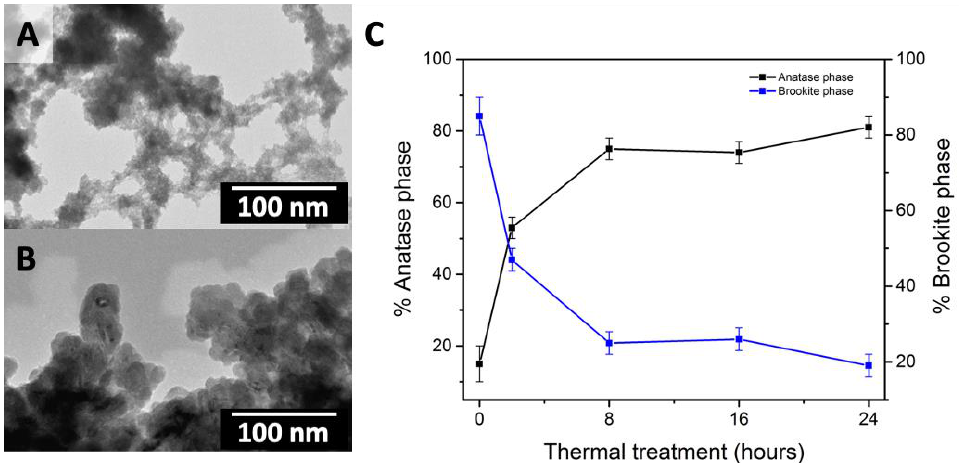
Figure 2. Transmission electron microscopy (TEM) micrographs of synthesized TiO 2 nanoparticles (NPs) before ( A ) and after the thermal treatment at 110 ◦ C in an oven carried out for 16 h ( B ). Panel ( C ) percentage of anatase and brookite phase in di ff erent samples estimated by quantitative phase analysis by X-ray di ff raction (XRD) pattern as a function of thermal treatment duration time at 110 ◦ C. Reprinted with permission from ref. [16].